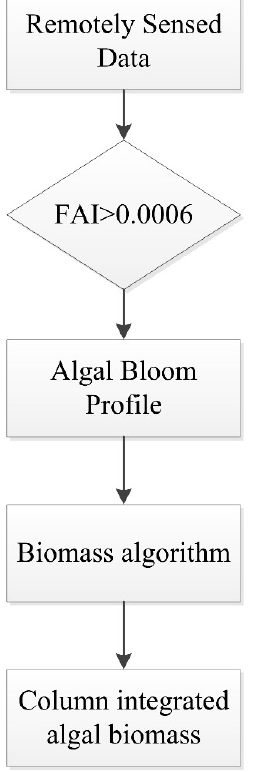
Figure 2. Schematic of the processing procedure of column-integrated algal biomass estimation.